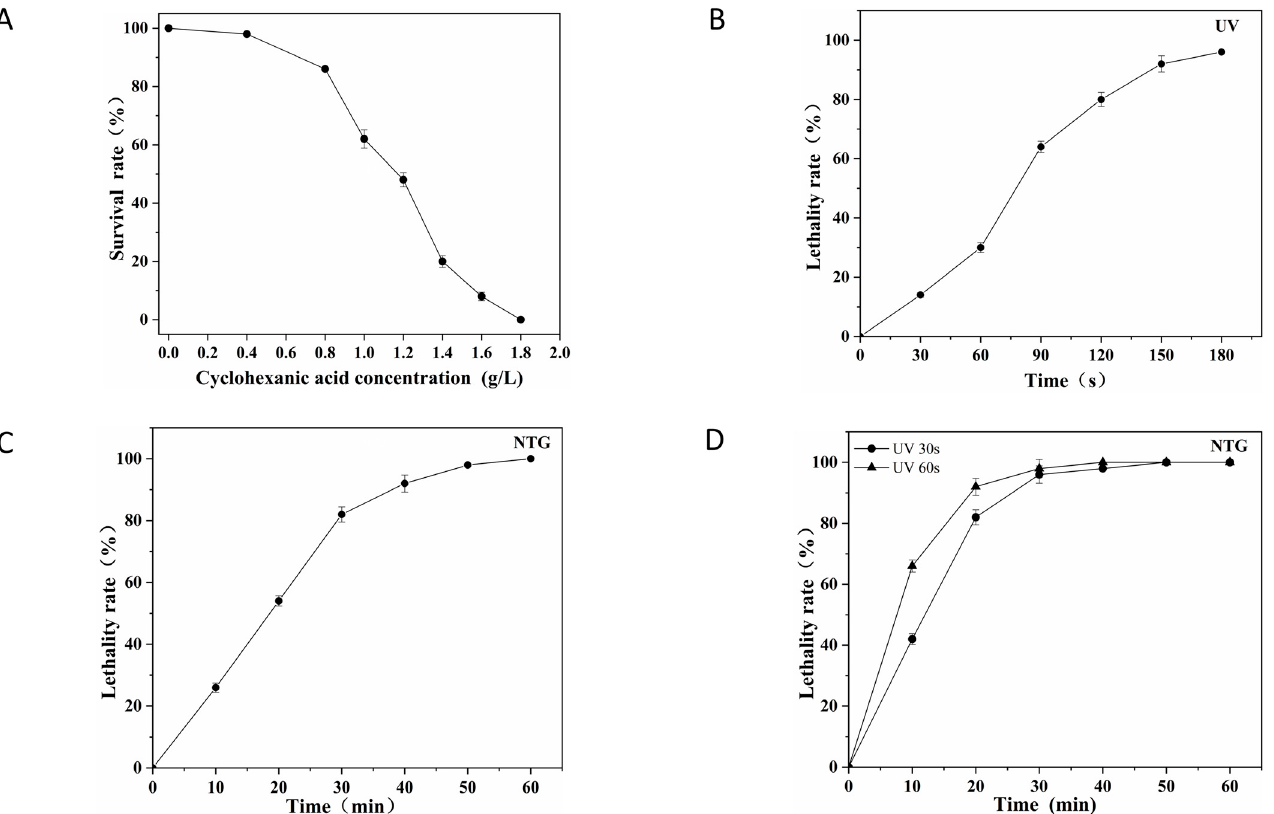
Figure 1. Assessment of CHC tolerance and the effect of mutagenic conditions on the viability of S. avermitilis N72. ( A ) The survival rate of S. avermitilis N72 at different concentrations of CHC, ( B ) lethality of S. avermitilis N72 by UV, ( C ) lethality of S. avermitilis N72 by NTG, ( D ) lethality of S. avermitilis N72 by the combined effect of UV and NTG.